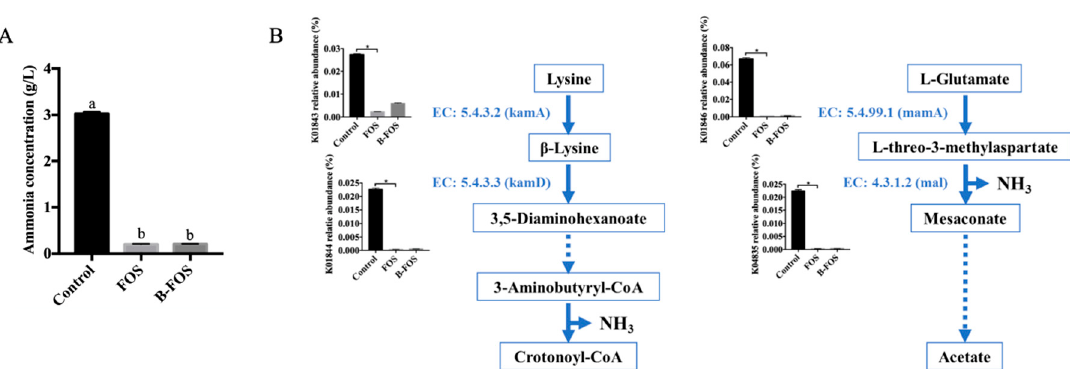
Figure 8. ( A ) Ammonia concentrations in fecal broth after 24 h culture. ( B ) Ammonia production pathways in Fusobacterium . Lysine 2,3-aminomutase (kamA), beta-lysine 5,6-aminomutase (kamD), methylaspartate mutase (mamA), methylaspartate ammonia lyase (mal). Arrows indicate the related genes that are involved in the corresponding pathway. Error bars represent means ± SD of triplicate cultures. Treatments with different letters are significantly different at p < 0.05. Significance was accepted at * p < 0.05 ( n = 3).